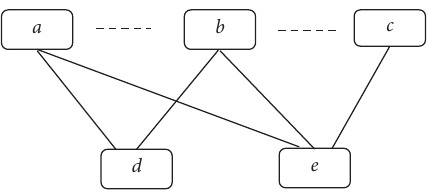
Figure 1: Generalized graphical model as a Bayesian network. Source: own